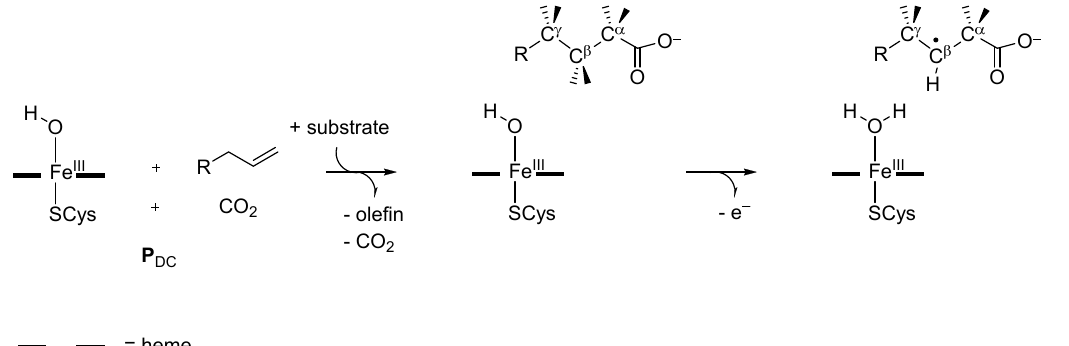
Scheme 4. Alternative mechanism for second substrate activation during the catalytic cycle of P450 OleT JE OleT JE .